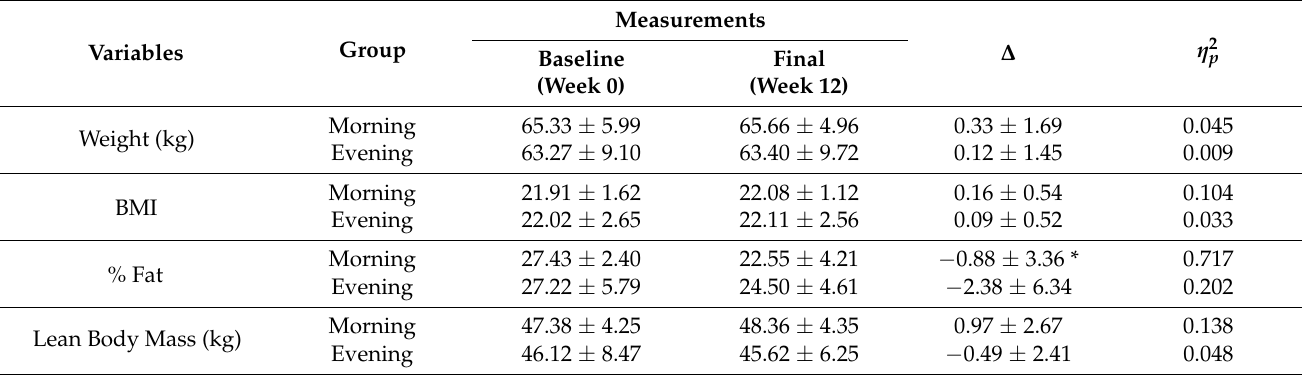
Table 1. Changes in body composition and sports performance variables in the morning and evening groups of female handball players after 12 weeks of